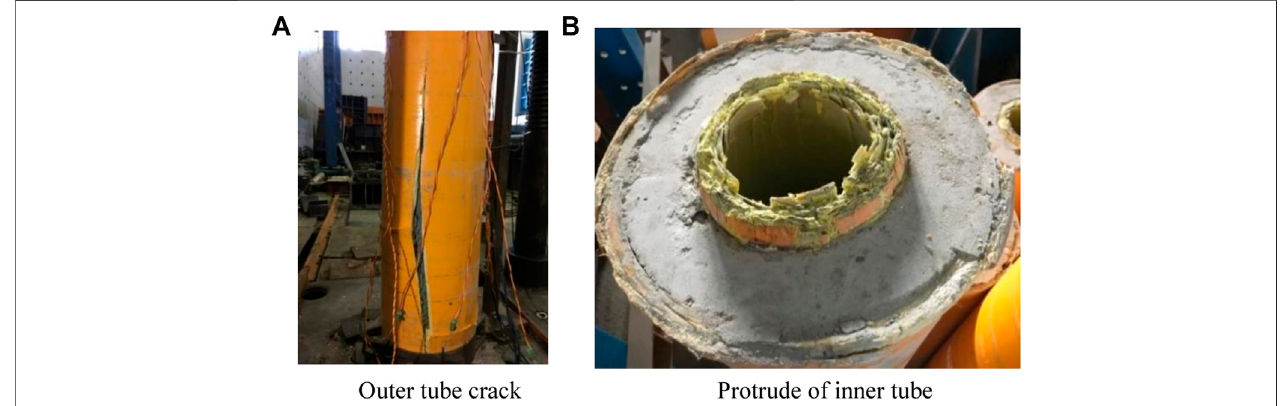
FIGURE 4 | Failure mode of test specimens. (A) Outer tube crack (B) Protrude of inner tube.